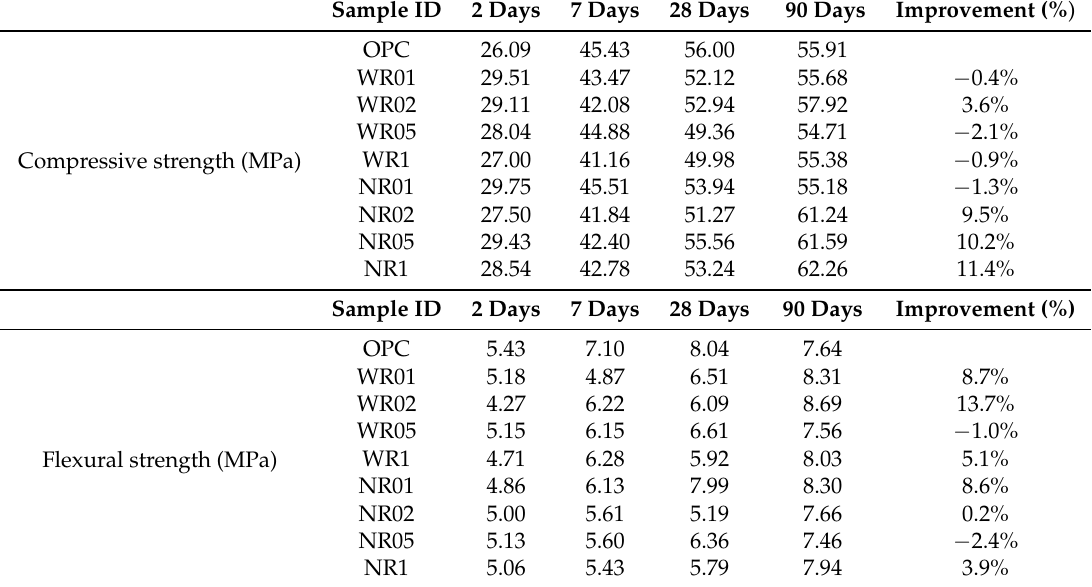
Table 1. Compressive and flexural strength of cement mortars containing nano-TiO to 400 ◦